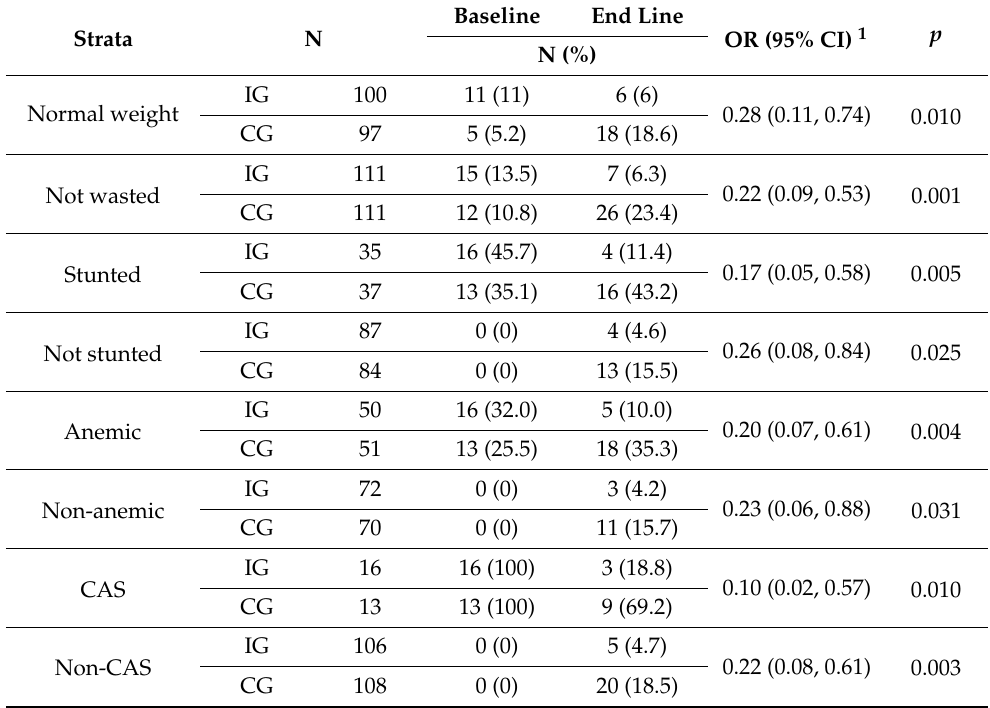
Table 4. Intervention effect on CAS among the groups stratified by baseline nutrition, anemia, and CAS